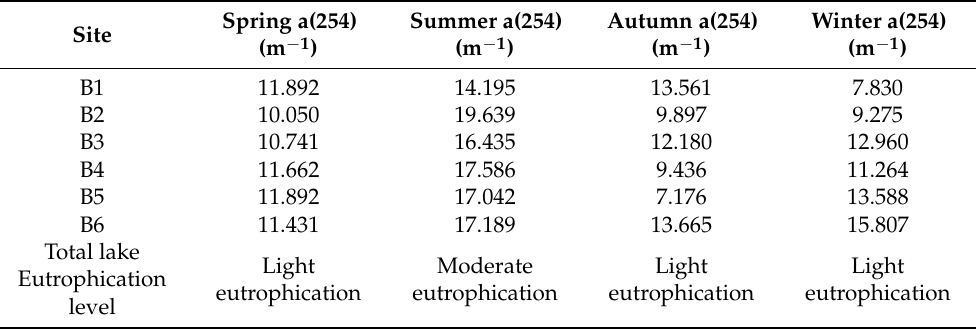
Table 2. Absorption coefficient of CDOM at 254 nm in different seasons of Bao’an Lake and corre- sponding evaluation